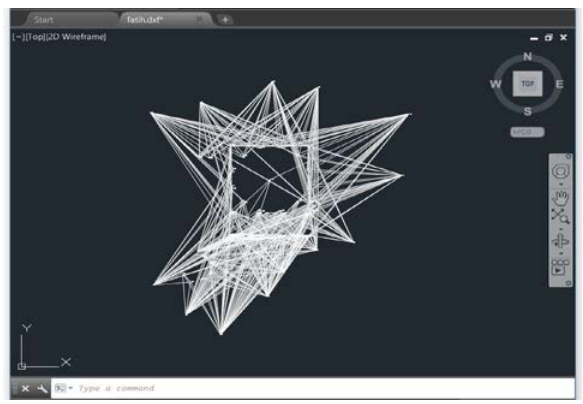
Figure 5. Orientation network of the spherical panoramas (outdoor)